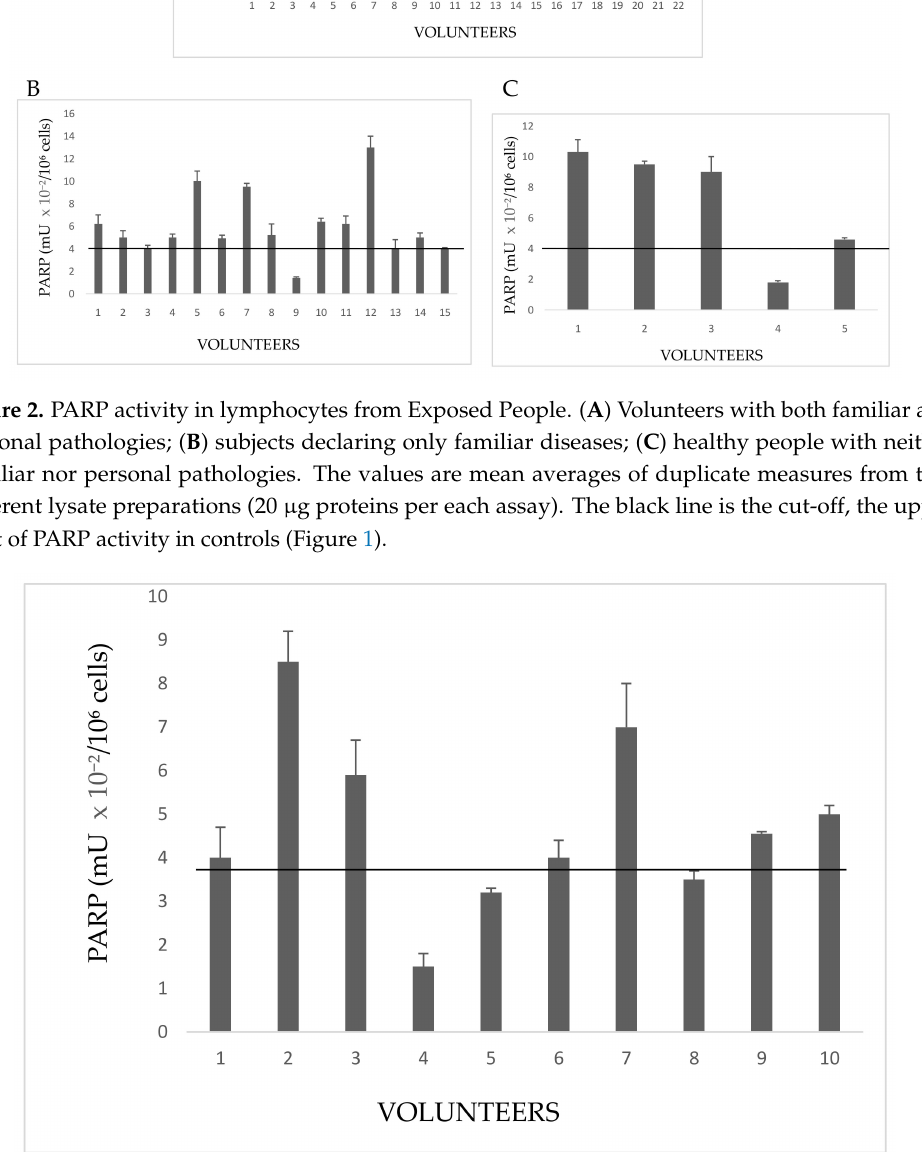
Figure 3. Activity in lymphocytes from indirectly exposed people. The values are mean averages of duplicate measures from two different lysate preparations (20 µ g Proteins per each assay). The black line is the cut-off, the upper limit of PARP activity in controls (Figure